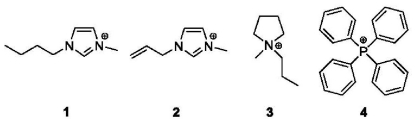
Organic cations of 57FeCl4 salts 1–4.